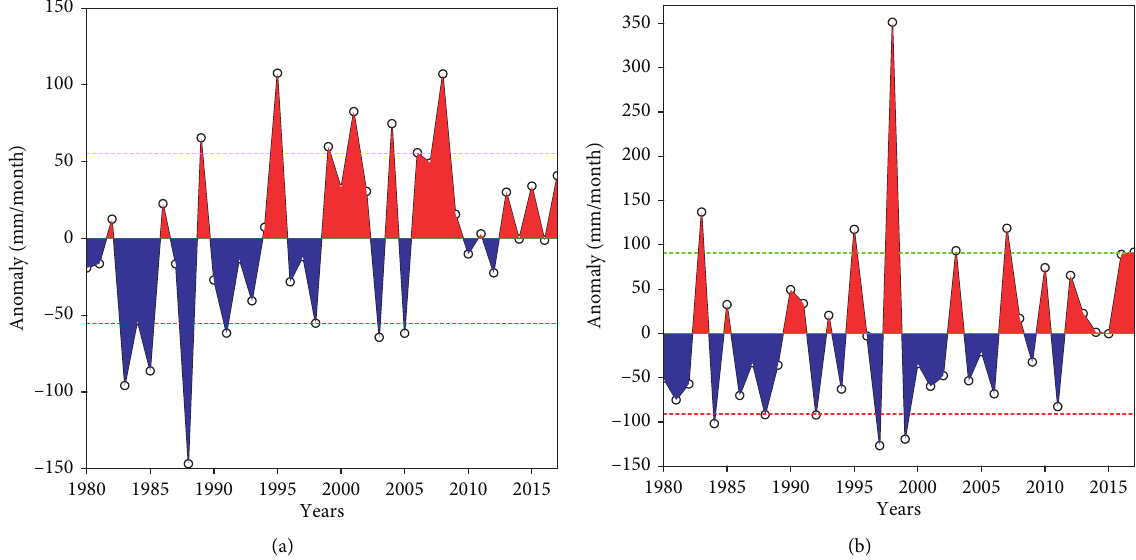
Figure 4: Time series of (a) summer rainfall averaged in the JJAS region and (b) autumn rainfall averaged in the OND region. The horizontal red lines in each panel are the ± 1 standard